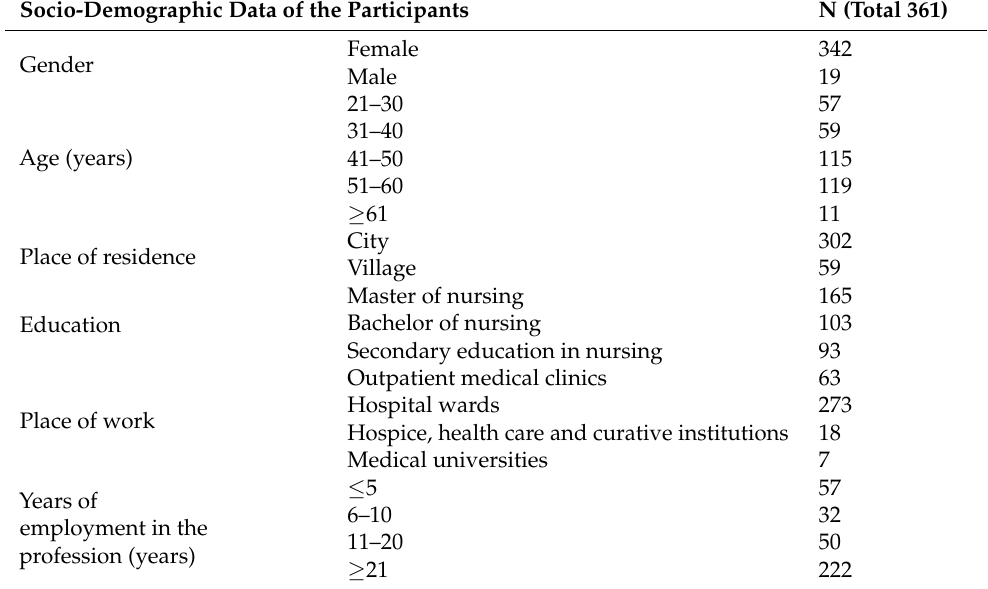
Table 1. Characteristics of the nurses.